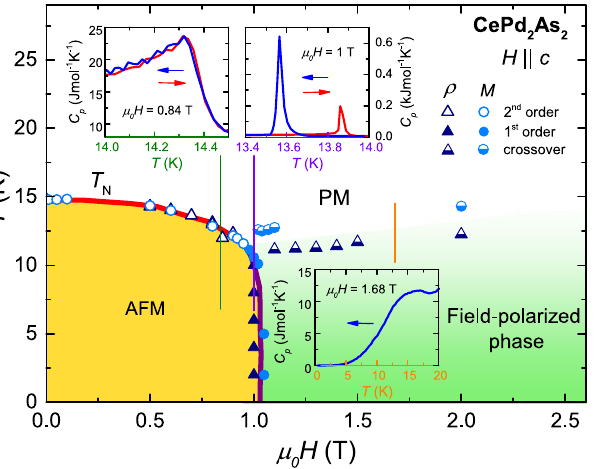
Figure 8. Magnetic phase diagram of CePd 2 As 2 for H c summarising the results from magnetisation and electrical resistivity data. The lines are guides to the eyes. The three insets present the temperature dependence of the specific heat at three representative magnetic fields as indicated by the vertical lines. The red and blue arrows in the insets indicate the direction of the temperature